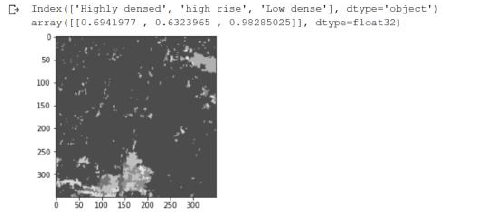
Figure 26 . Result of 350 X 350 Amplitude Image.